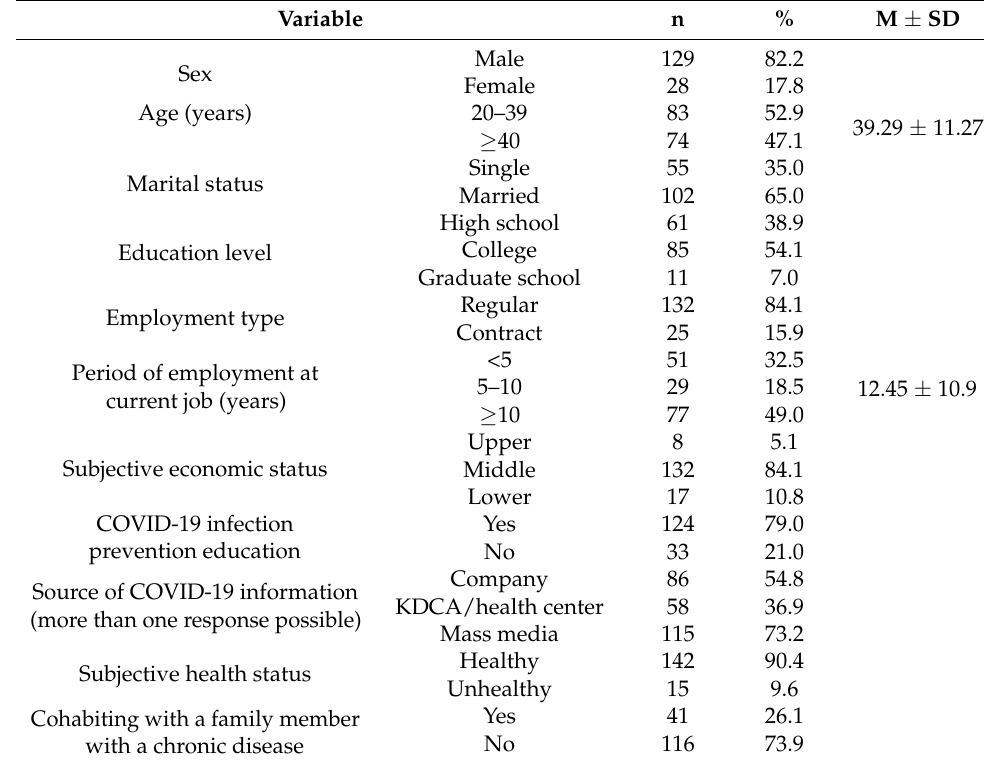
Table 1. General characteristics of the participants’ variables (N =